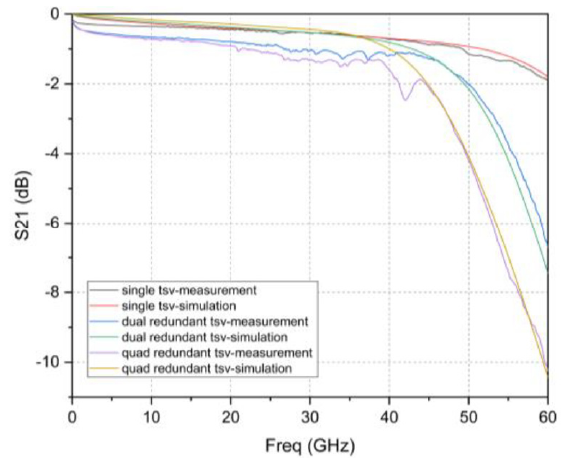
Figure 12. Test structure S 21 parameter measurement results and optimized simulation results of HFSS.